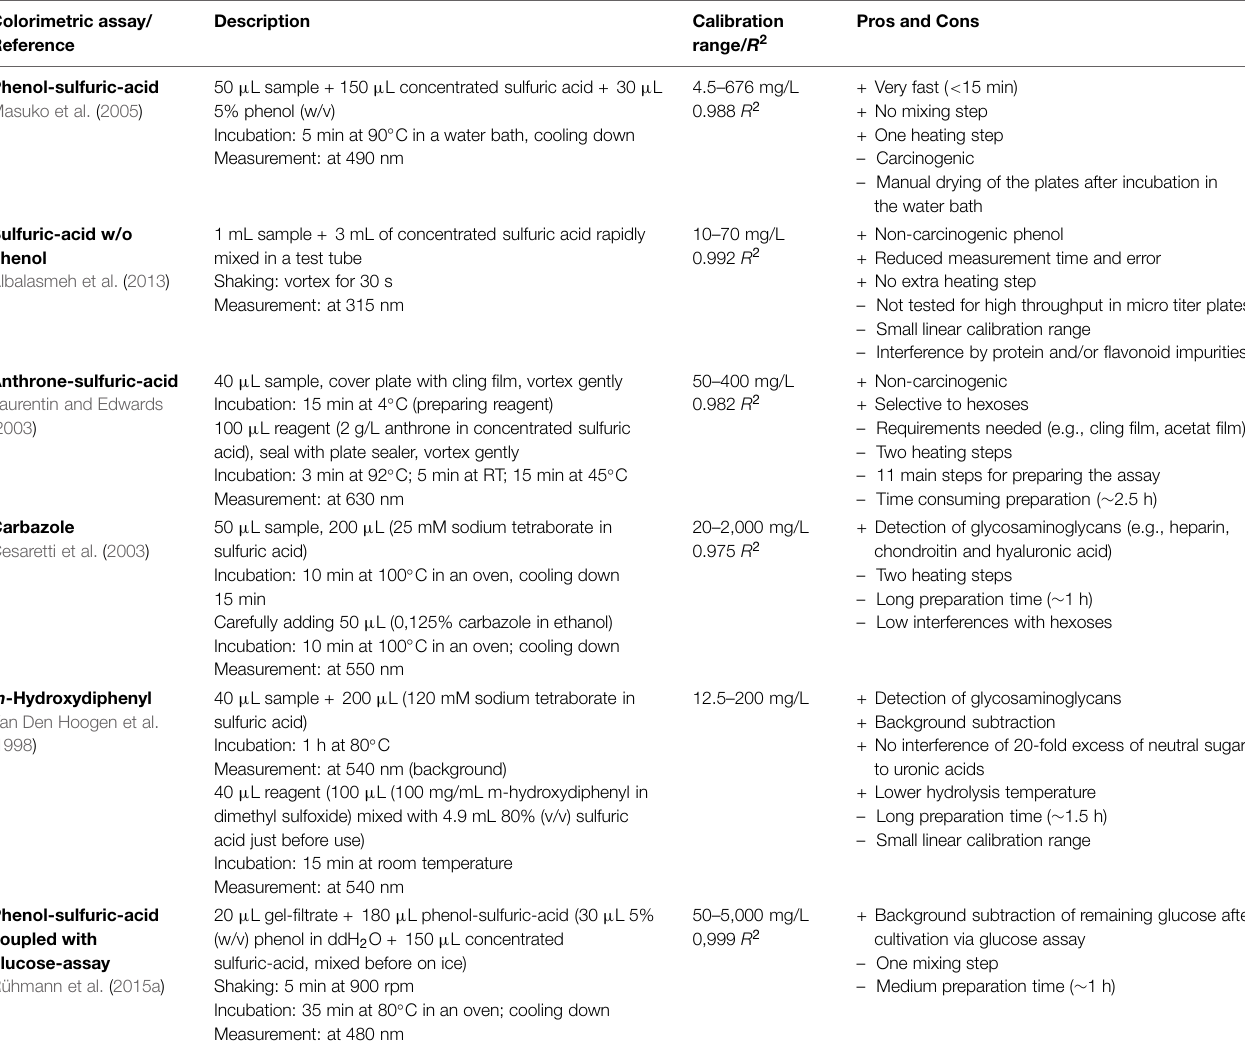
TABLE 2 | Overview and description of different micro-titer based colorimetric assays including benefits and disadvantages. Colorimetric assay/